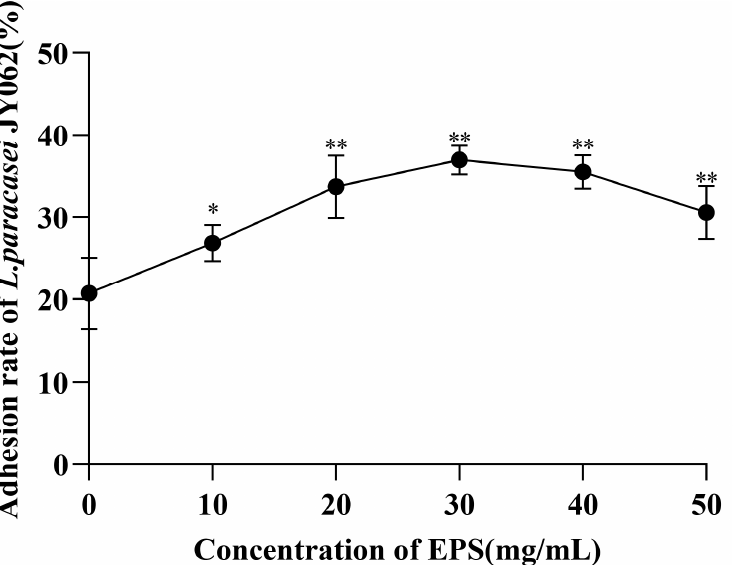
Figure 2. Effect of EPS concentration on the adhesion rate of L. paracasei JY062 . (* p < 0.05, ** p < 0.01).